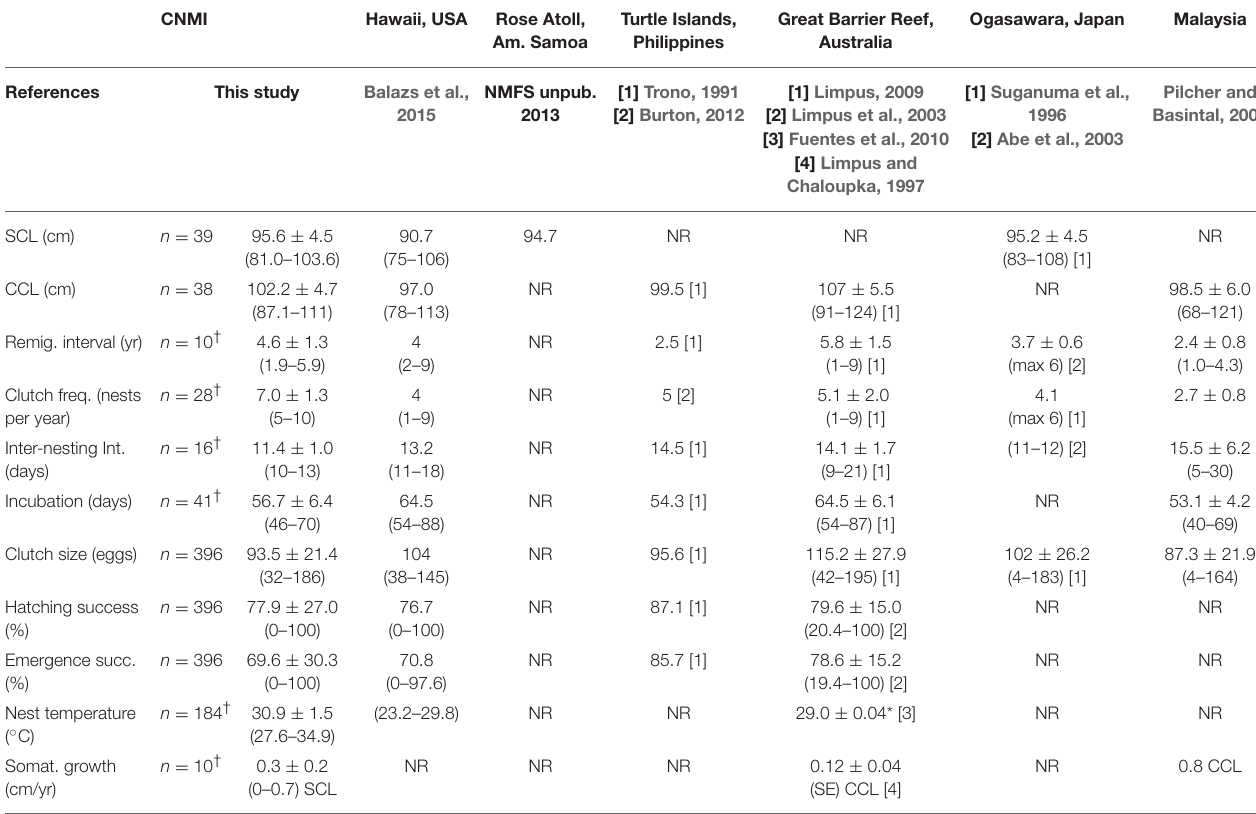
TABLE 2 | Reproductive parameters for green turtles ( Chelonia mydas ) nesting in the Commonwealth of the Northern Mariana Islands (CNMI) on Saipan, Tinian, and Rota islands.